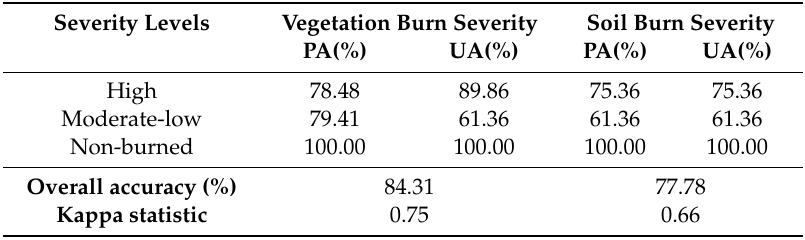
Table 2. Overall, producer (PA), user (UA) accuracy and Kappa statistic for vegetation and soil burn severity